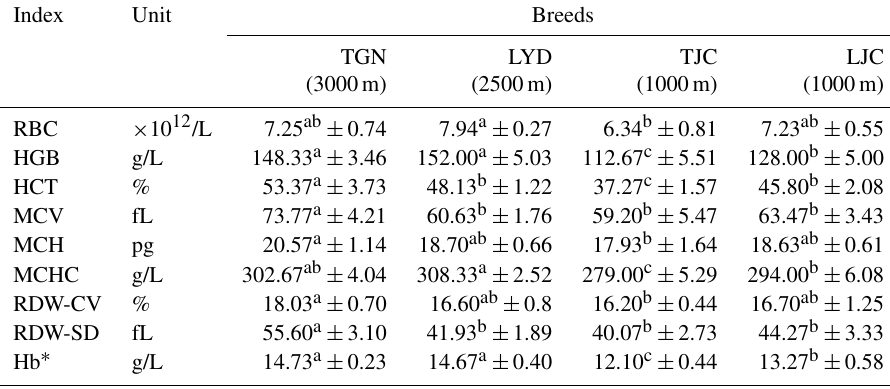
Table 3. Blood physiological indexes of the pigs.